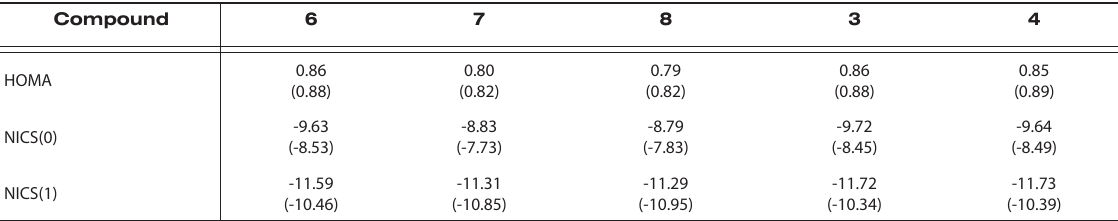
Table 3. Aromaticity data for carbocyclic and heterocyclic (in parentheses) rings of optimized